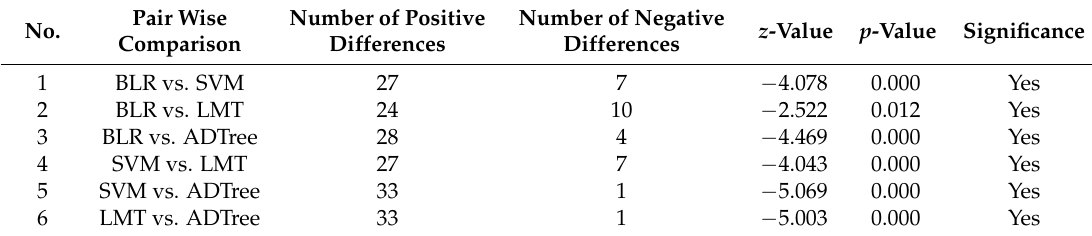
Table 4. Performance comparison of the machine learning models in land subsidence using Wilcoxon signed-rank test (two-tailed). The standard p -value is